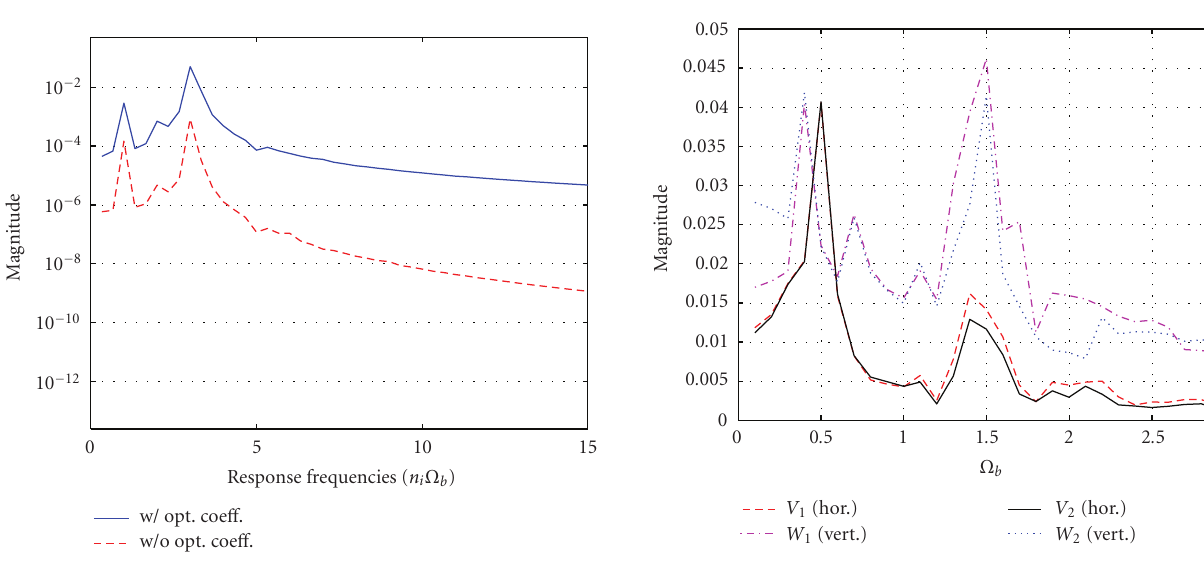
Figure 16: RMS plots for 4 DOF